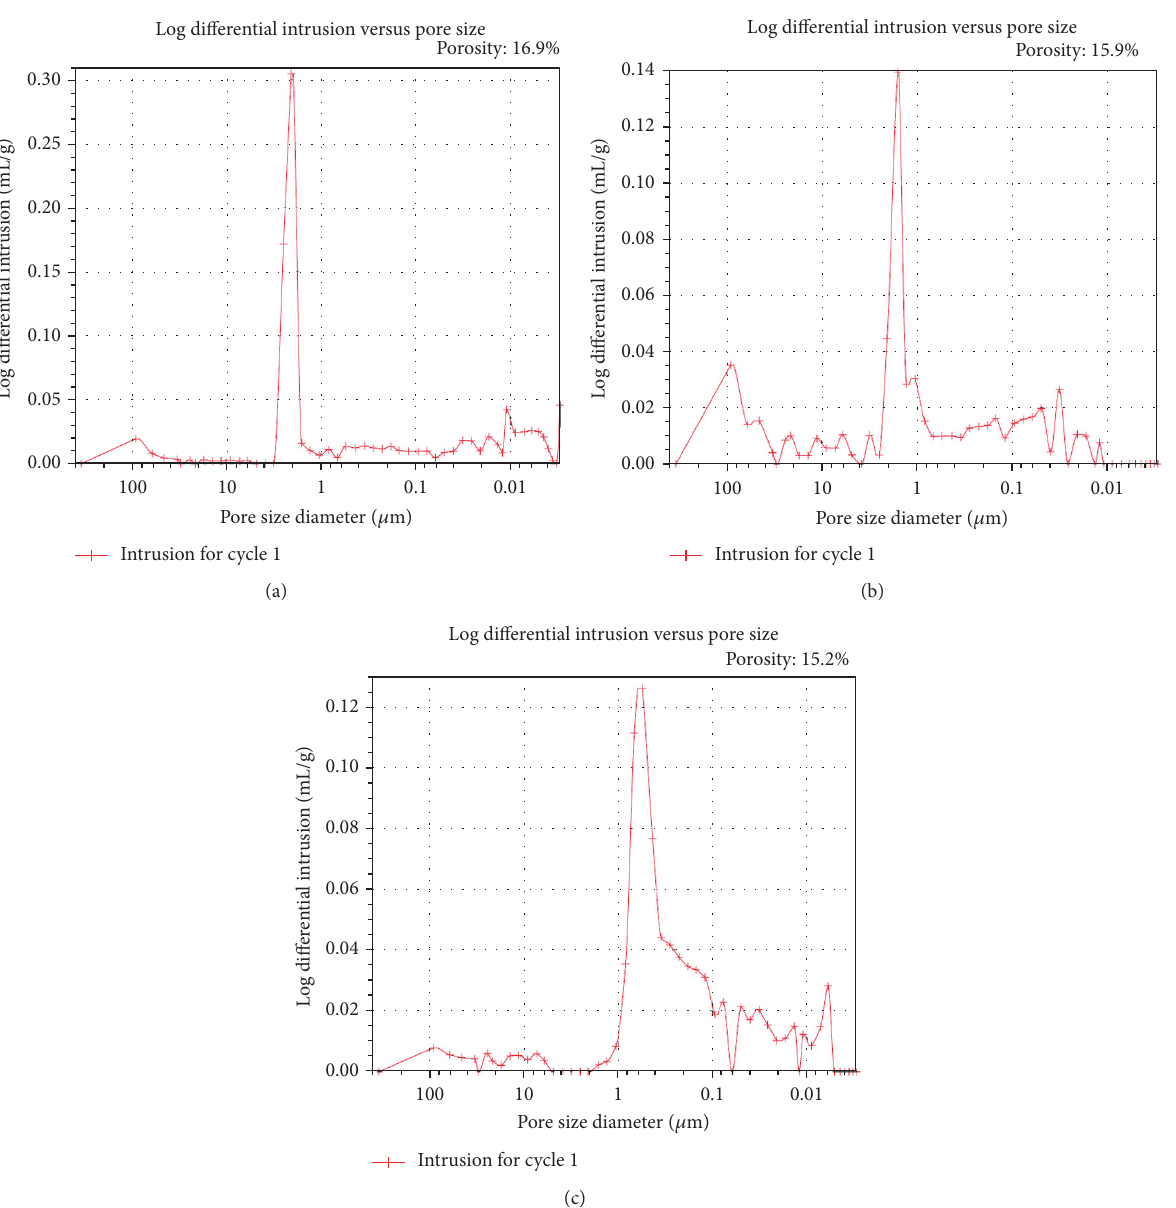
Figure 6: Pore size distribution and porosity for (a) graphite, SiC-coated graphite prepared (b) at reaction zone (1) and (c) at reaction zone